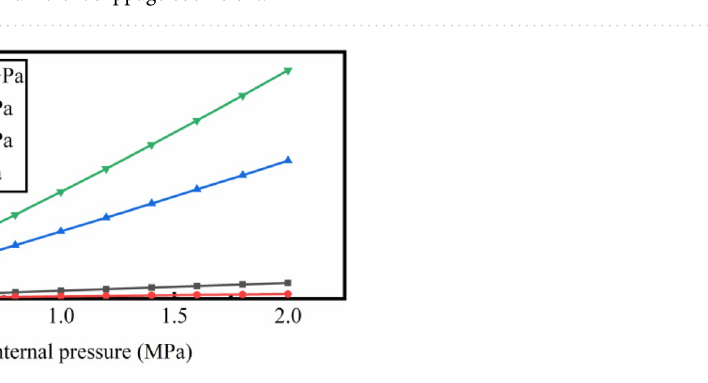
Figure 11. The maximum deformation vs. the internal pressure with variant reinforced fibers (Polyamide 66 – 5 GPa; Polyester– 18 GPa; Kevlar 29 – 71 GPa; Zylon – 280 GPa).